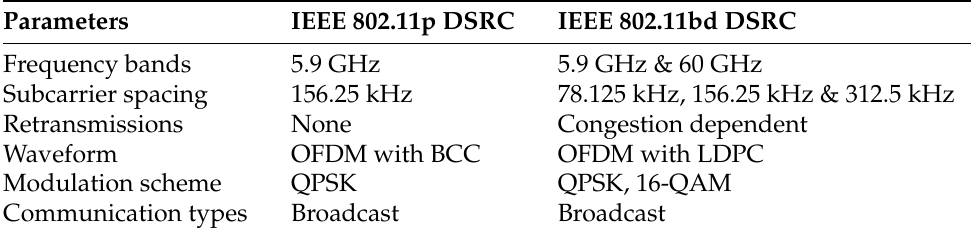
Table 3. Comparison between specifications of IEEE 802.11p and IEEE 802.11bd DSRC [56]. Parameters